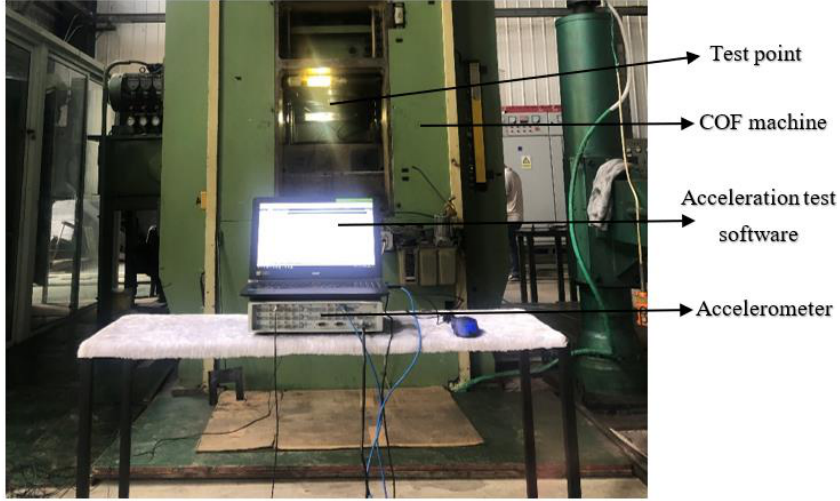
Figure 5. The acceleration test experiment.